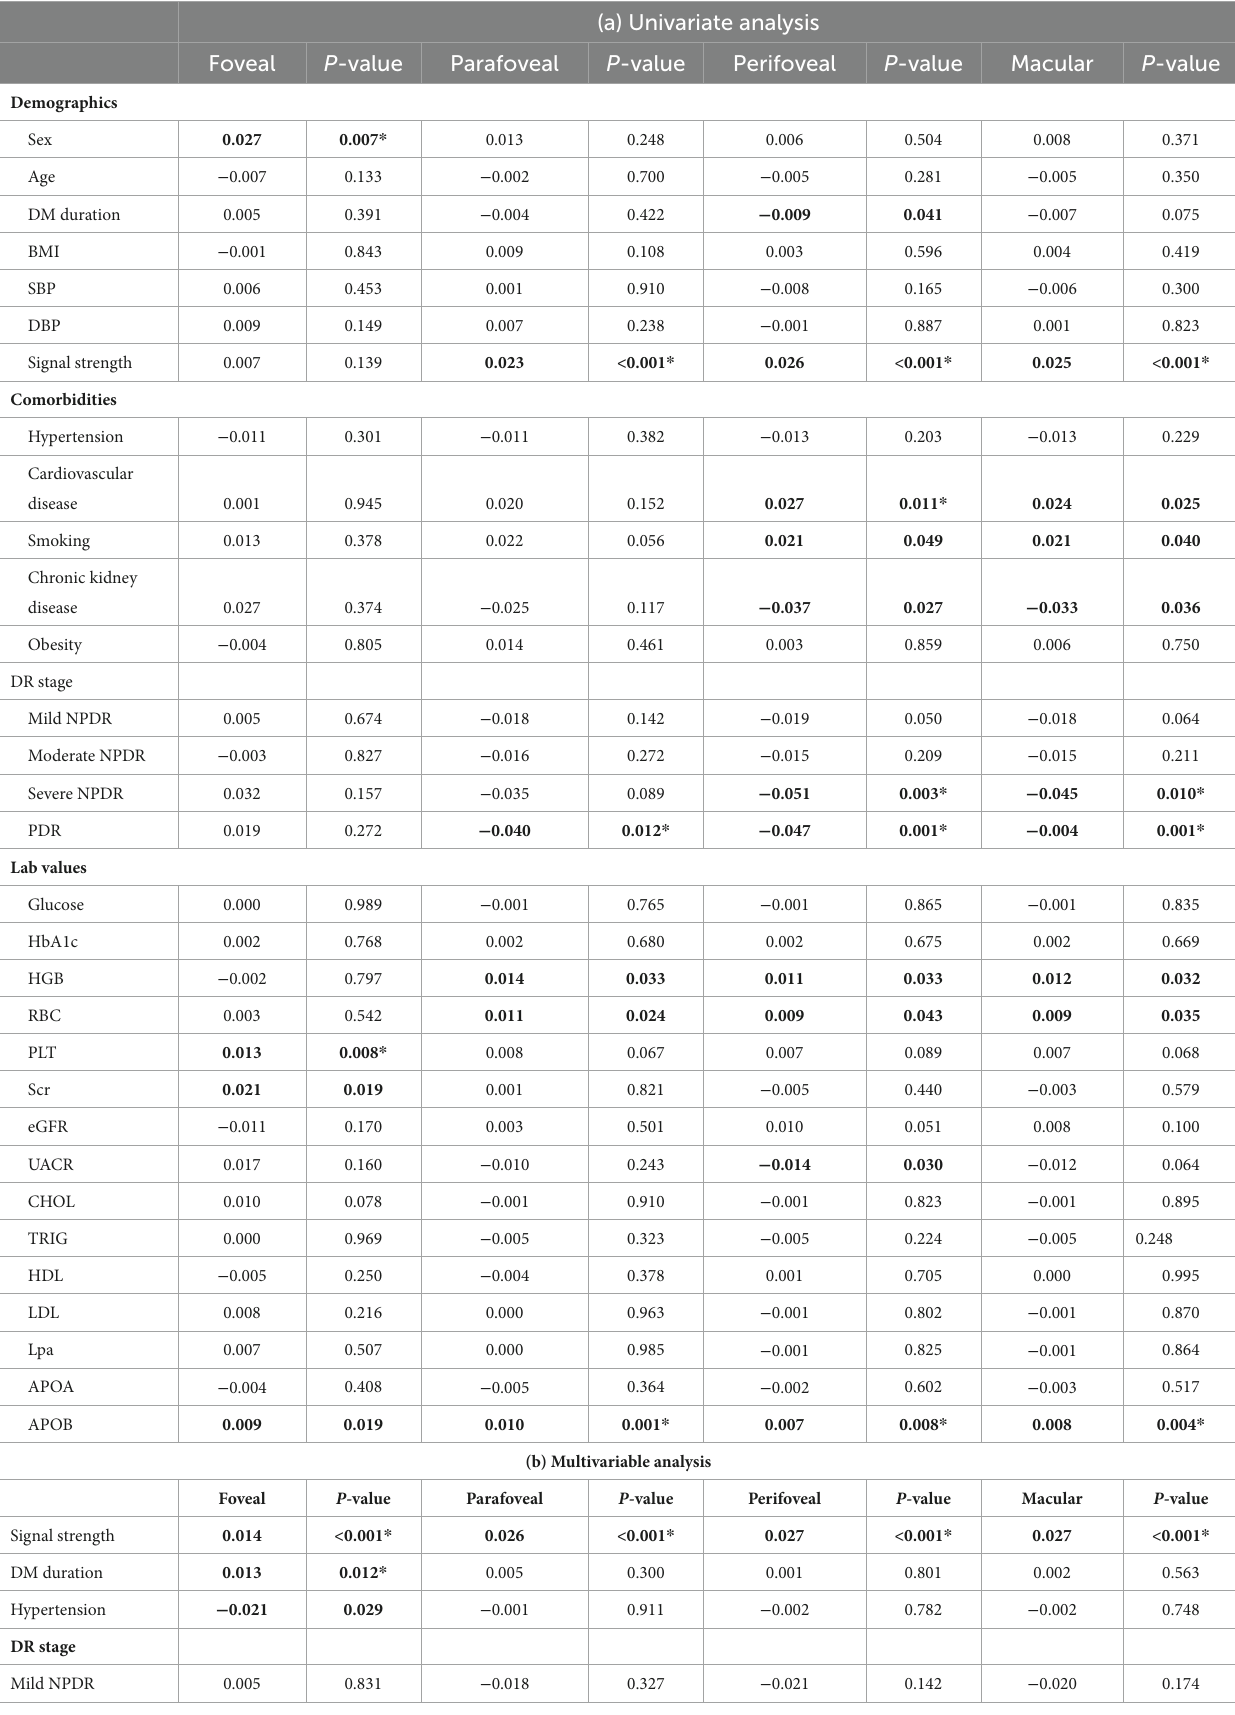
(a) Univariate analysis Foveal P -value Parafoveal P -value Perifoveal P -value